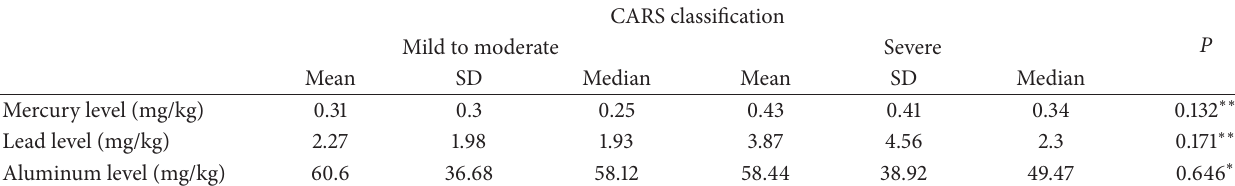
Table 7: Comparison between CARS degrees and levels of heavy metals. CARS